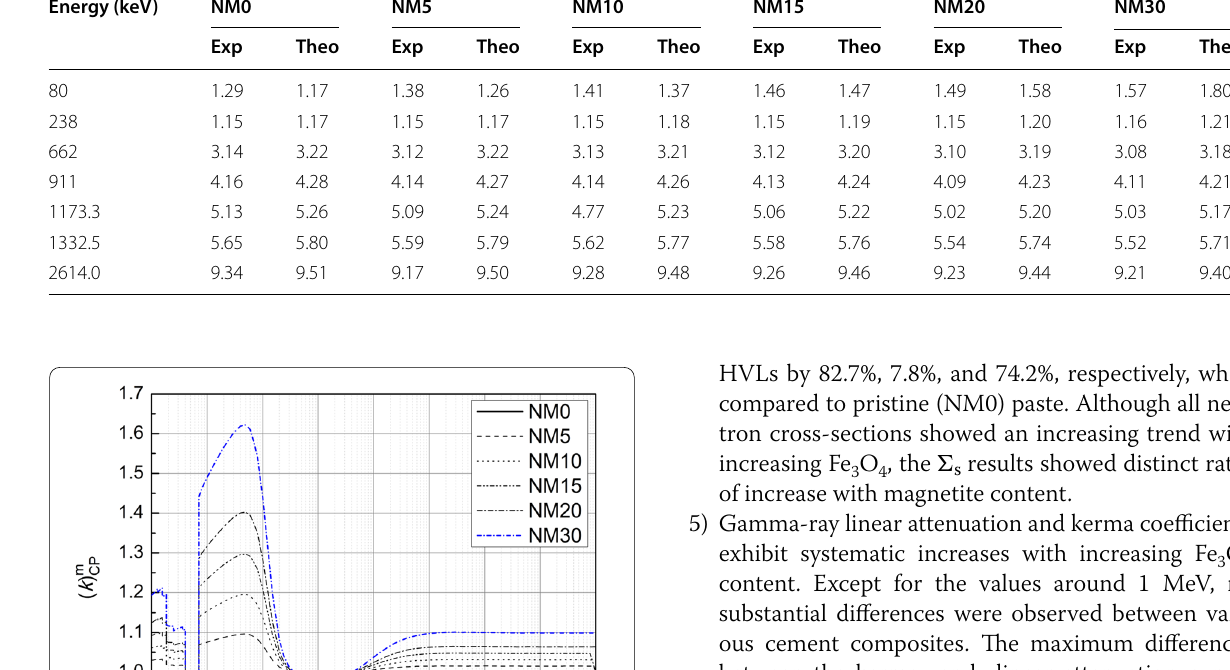
Table 6 Measured and theoretical kerma coefficients ( k, pGy.cm 2 /photon) of cement pastes modified with Fe experimental error was less than 5% Energy (keV)